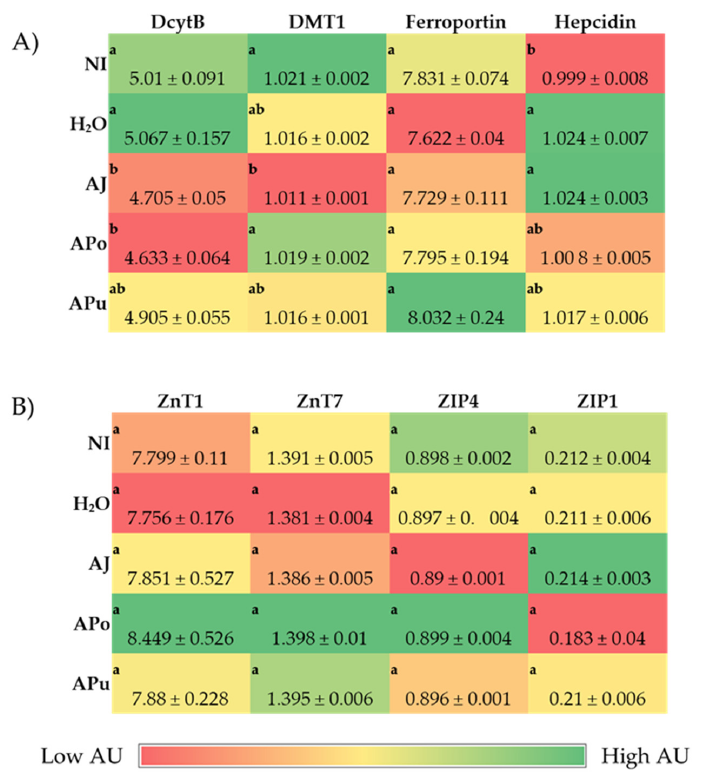
Figure 1. Effect of intra-amniotic administration of apple fraction soluble extracts on iron ( A ) and zinc ( B ) intestinal and liver (Hepcidin) gene expression. Values are the means ± SEM, n = 5. a, b Per gene, treatment groups not indicated by the same letter in the same column are significantly different ( p < 0.05) by Duncan’s post-hoc test. DcytB, Duodenal cytochrome B; DMT1, Divalent metal transporter 1; Zinc transporters: ZnT1, ZnT7, ZIP4, ZIP1; AU, Arbitrary units.